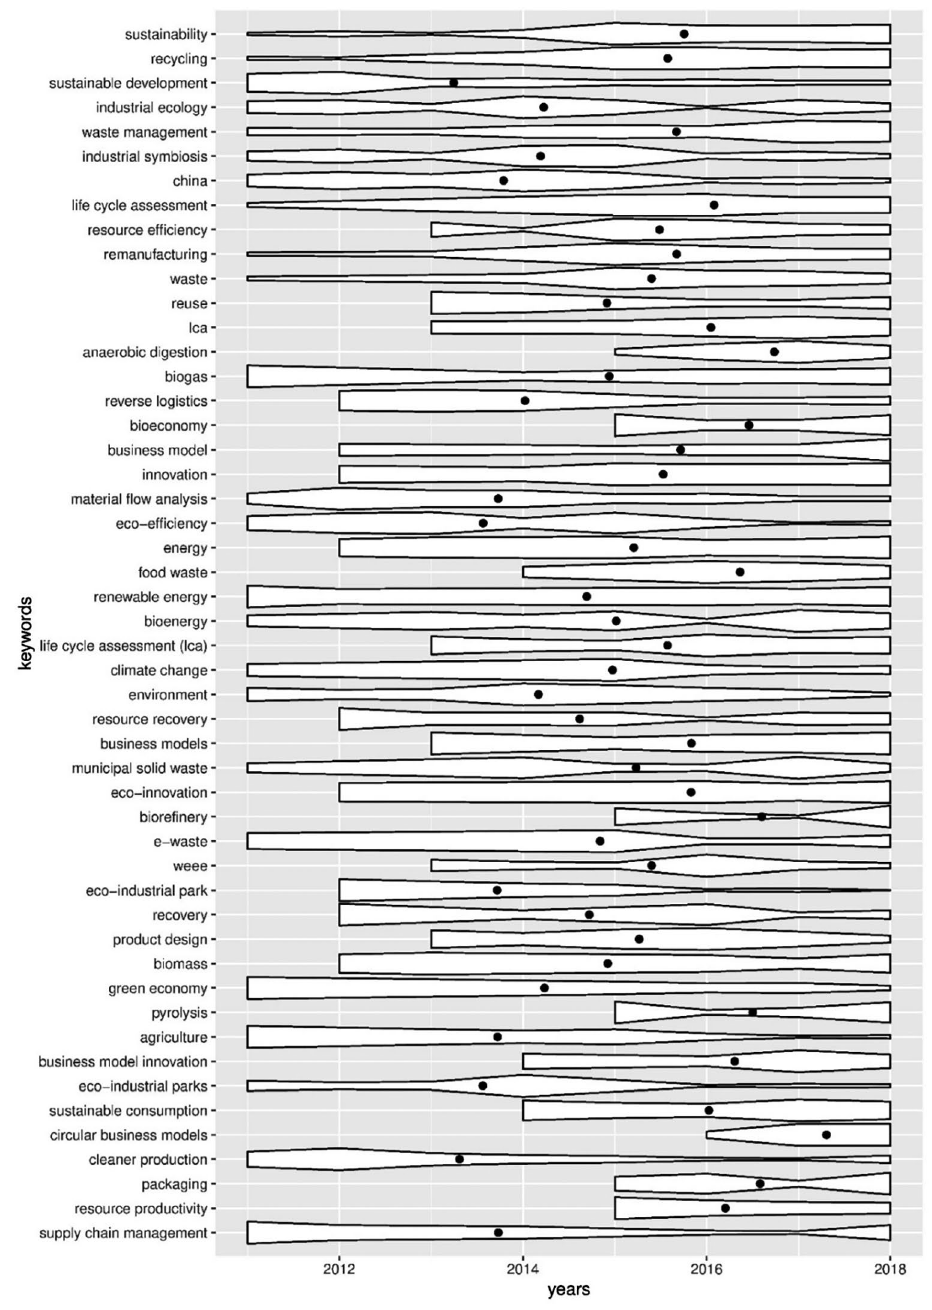
Figure 1. Normalized ribbon graph of the top 50 keywords (by occurrences), the evolution of relative importance (2011–2018) illustrated by width (source: own study based on Web of Science and